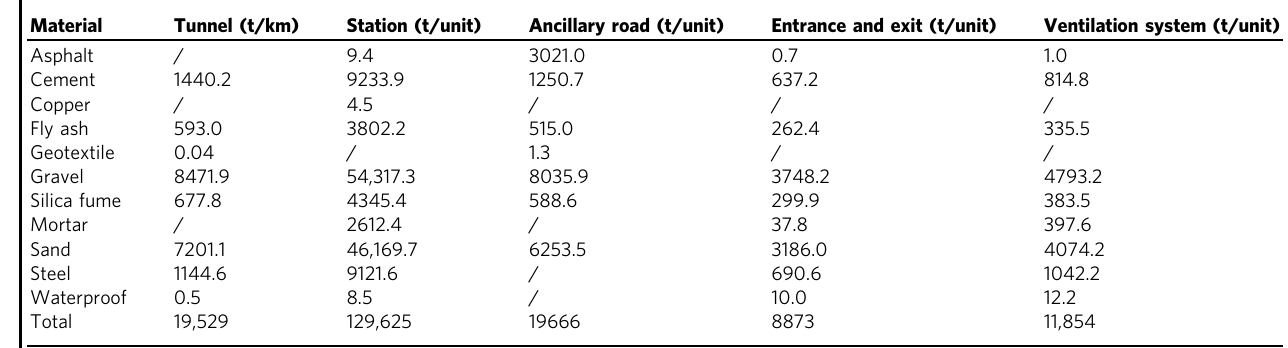
Table 1 Subway material composition indicators (MCIs) of Chinese